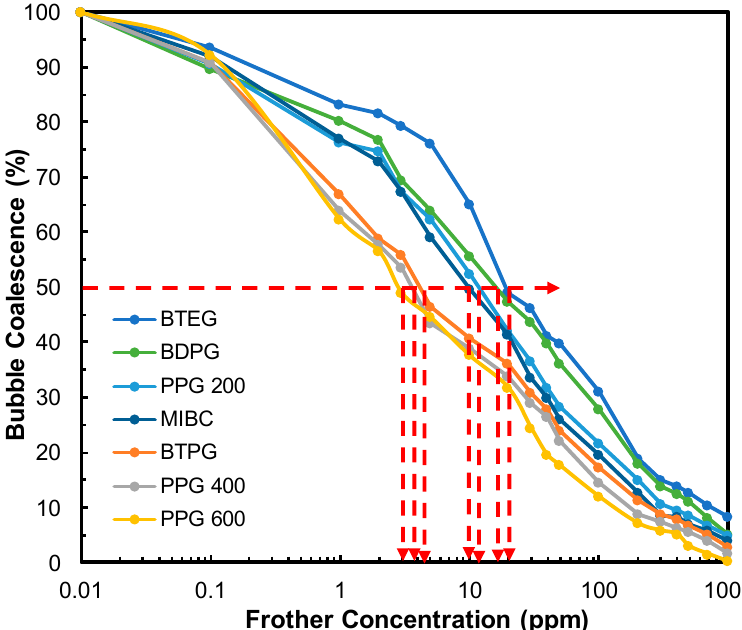
Figure 3. Variation of % bubble coalescence against concentration of different frothers.